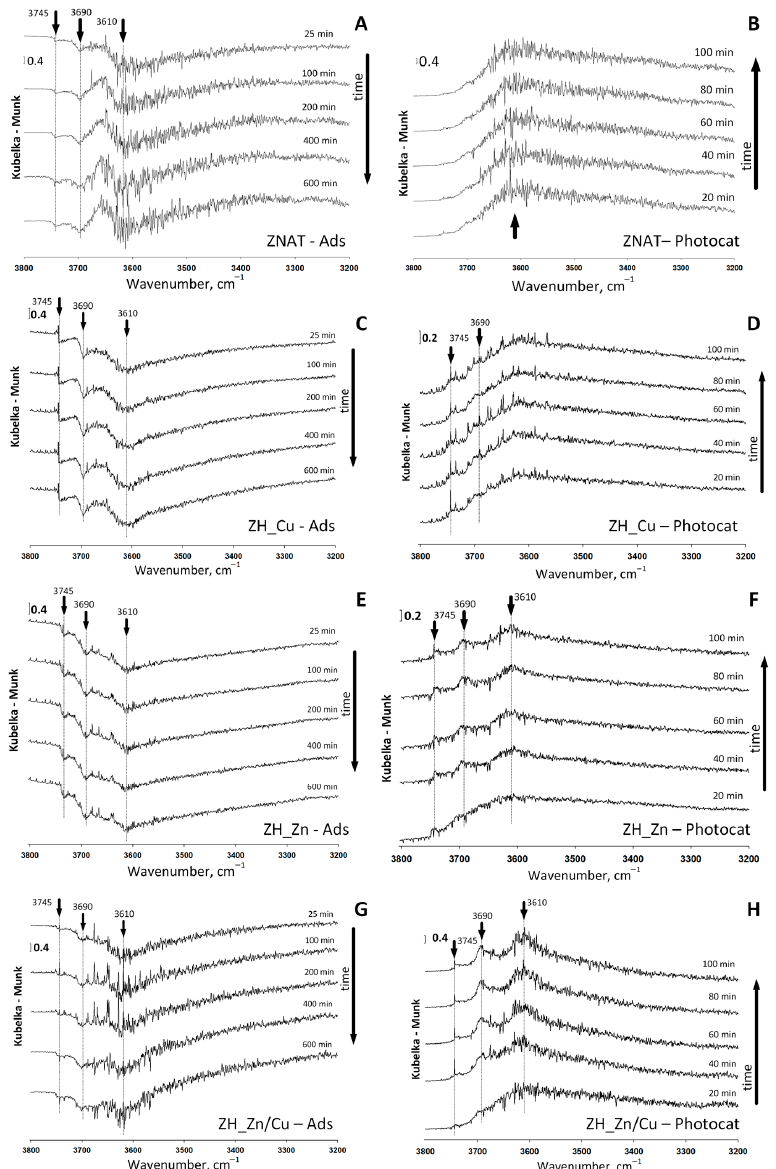
Figure 7. Evolution of subtracted DRIFTS spectra of the OH stretching vibration zone during the adsorption step (left) and photocatalytic degradation step of ethylene (right) onto parent zeolite support. Prepared single and double metal oxide catalysts supported on modified natural zeolite: ZNAT ( A , B ), ZH_Cu; ( C , D ); ZH_Zn ( E , F ); ZH_Zn/Cu; ( G , H ).